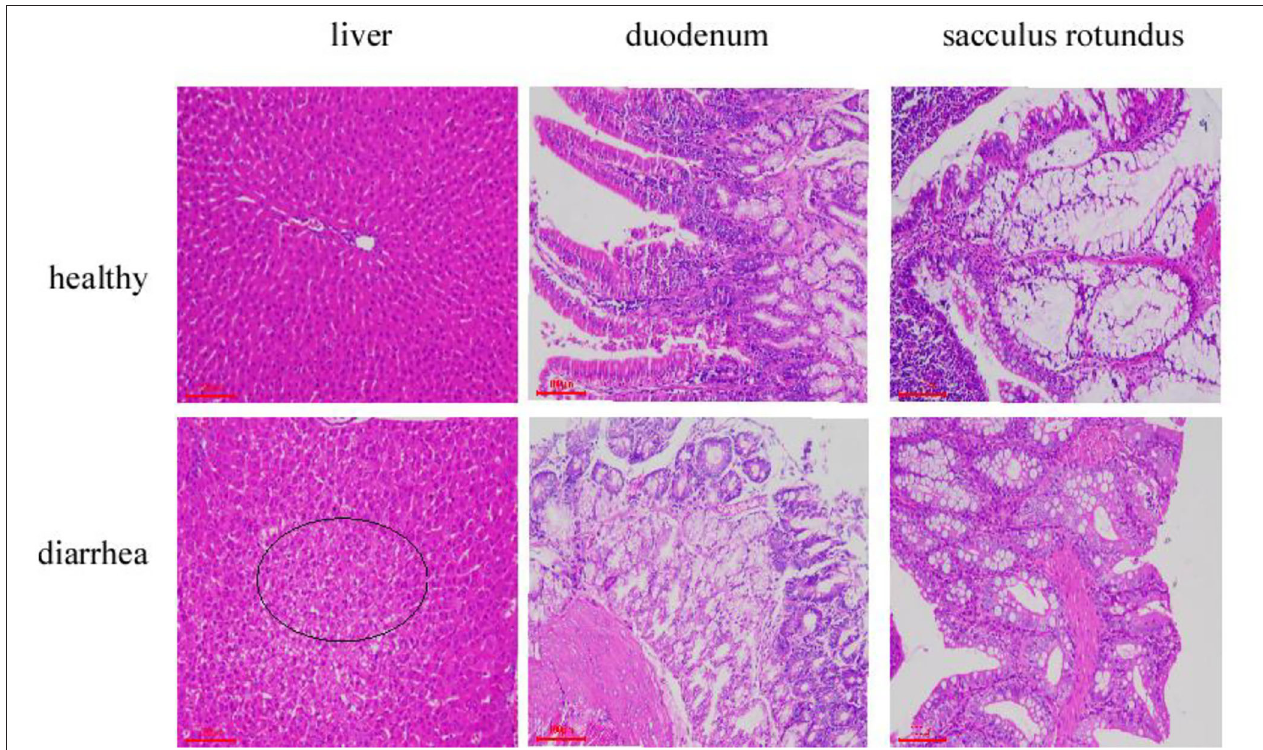
FIGURE 1 | Liver, duodenum, and sacculus tissue samples stained with hematoxylin and eosin ( × 100) from Hyplus rabbits fed either an antibiotic-free diet or a healthy diet. Black circles indicate pathological features.